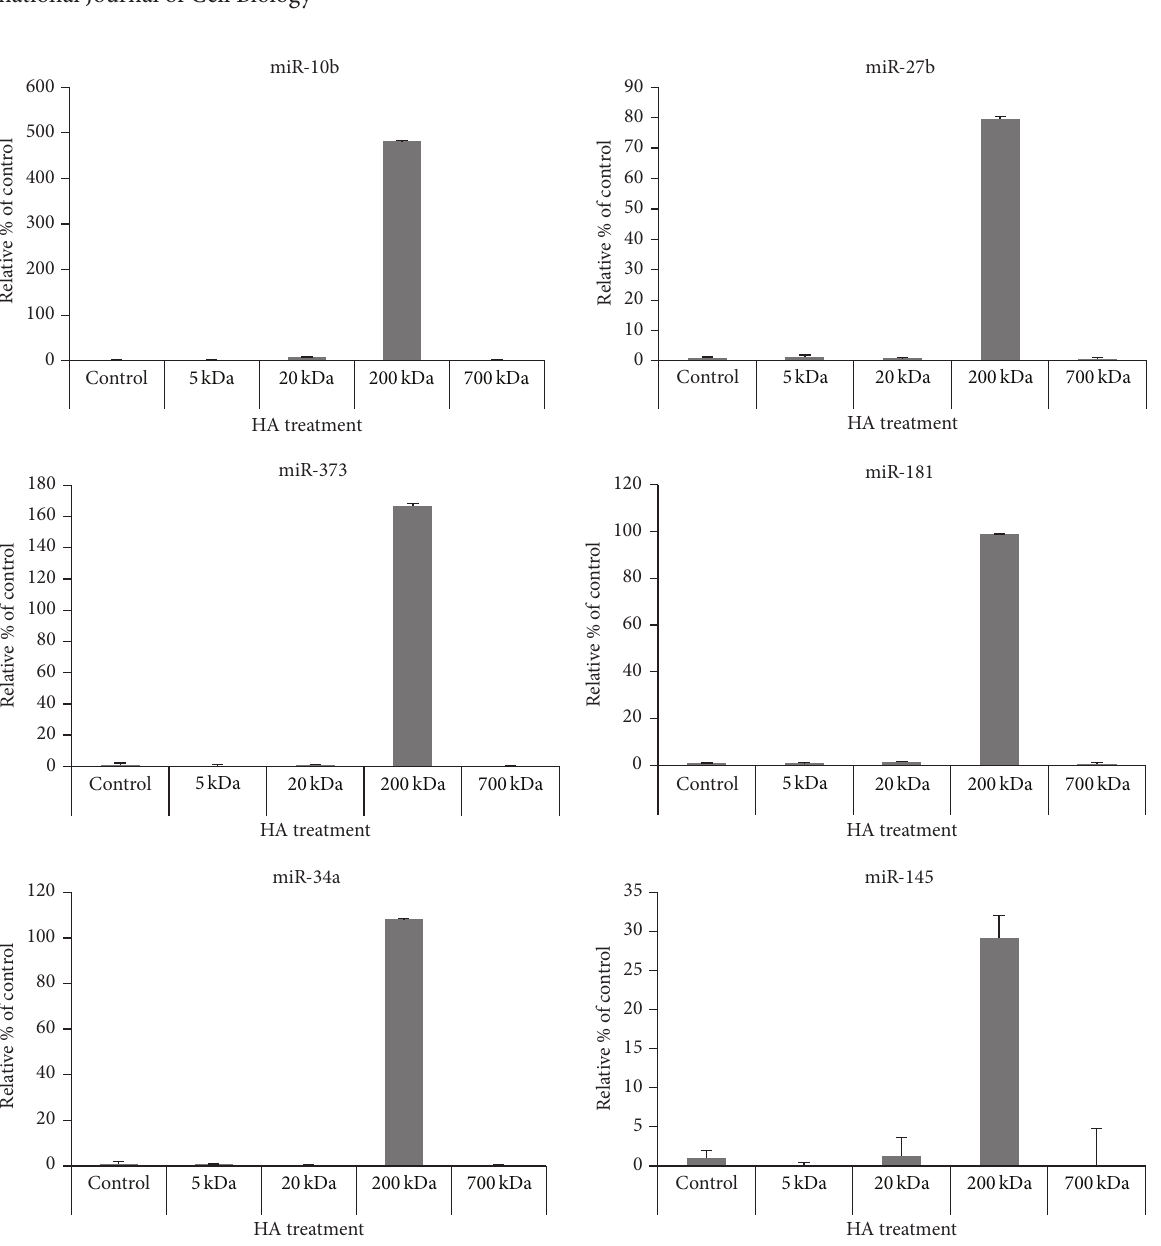
clone number to the planted cell